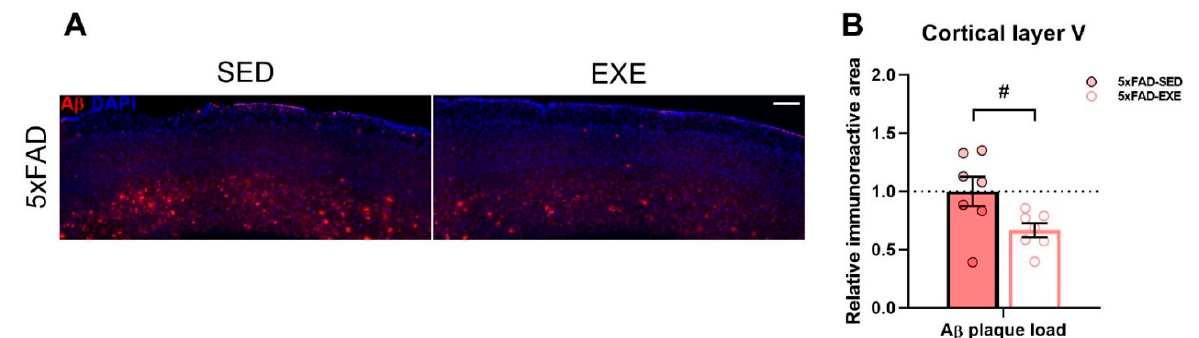
Figure 1. Effects of regular exercise on cortical A β load in the 5xFAD mouse model. ( A ) Representative images of A β staining in cortical layer V of 5xFAD-SED and 5xFAD-EXE mice. Scale bar 200 μ m. ( B ) Percentage of immunoreactive area was quantified to measure A β content in cortical layer V. All data are relative to 5xFAD-SED and presented as mean ± SEM. n = 8/group. « # » exercise effect: # p < 0.05.